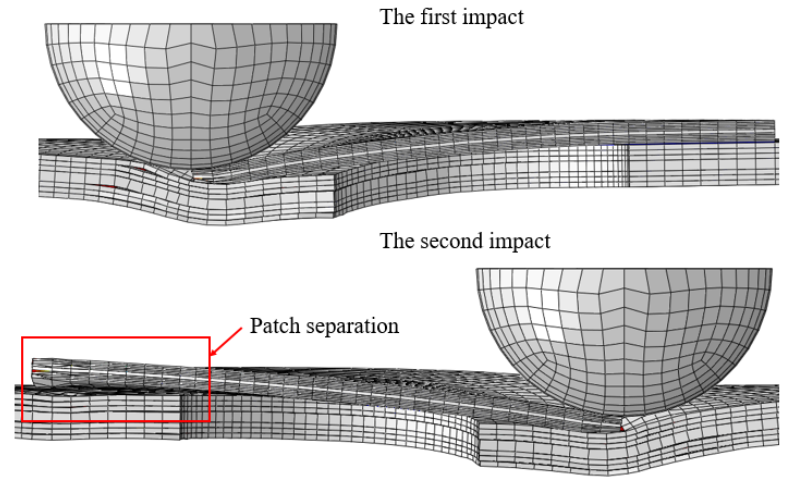
Figure 16. Contact between the impactor and the patch during the first impact and the second impact at the impact energy of 15 J.